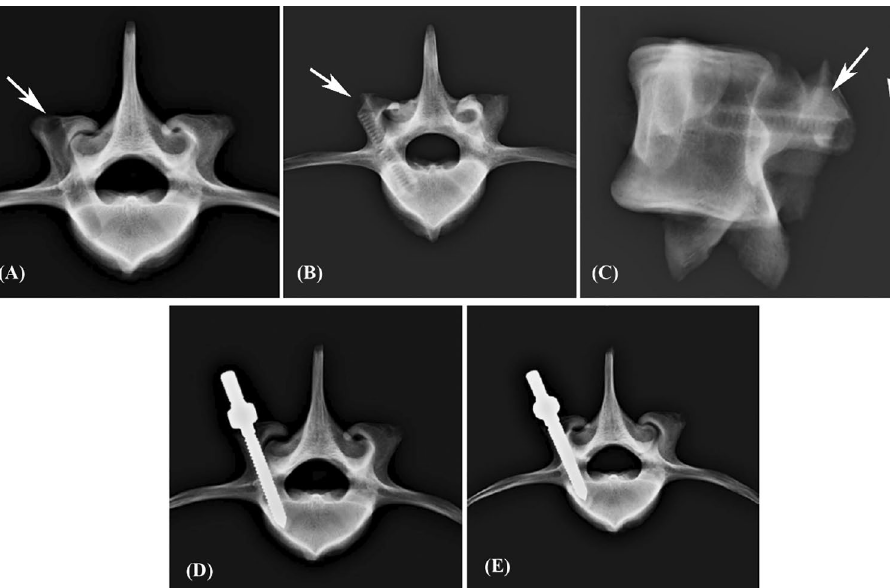
Figure 2. X-ray images of the modified group. An enlarged screw hole was prepared and confirmed using axial X-rays ( A ) (white arrow). A stiff threaded PMMA hole was confirmed by axial ( B ) and sagittal ( C ) X-ray images (white arrow). A cylindrical ( D ) or conical ( E ) repair screw was convergently implanted. The tip of the inserted screw did not exceed the enlarged depth, and no signs of fracture or damage were detected in the vertebrae.